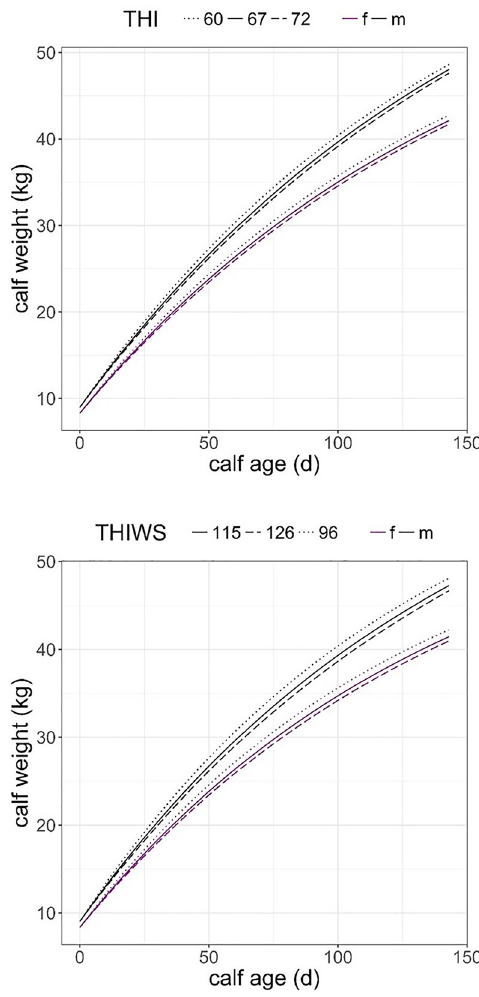
Fig 2. Predicted calf growth from birth to forced weaning (day 143) from models in Tables 2 and 3 for three values of THI heat stress index (60, 67, 72) corresponding to its quantiles 0.1, 0.5 and 0.9; and three values of THIWS (96, 115, 126) corresponding to quantiles 0.1, 0.5 and 0.9; f: female calf (magenta); m: male calf (black).